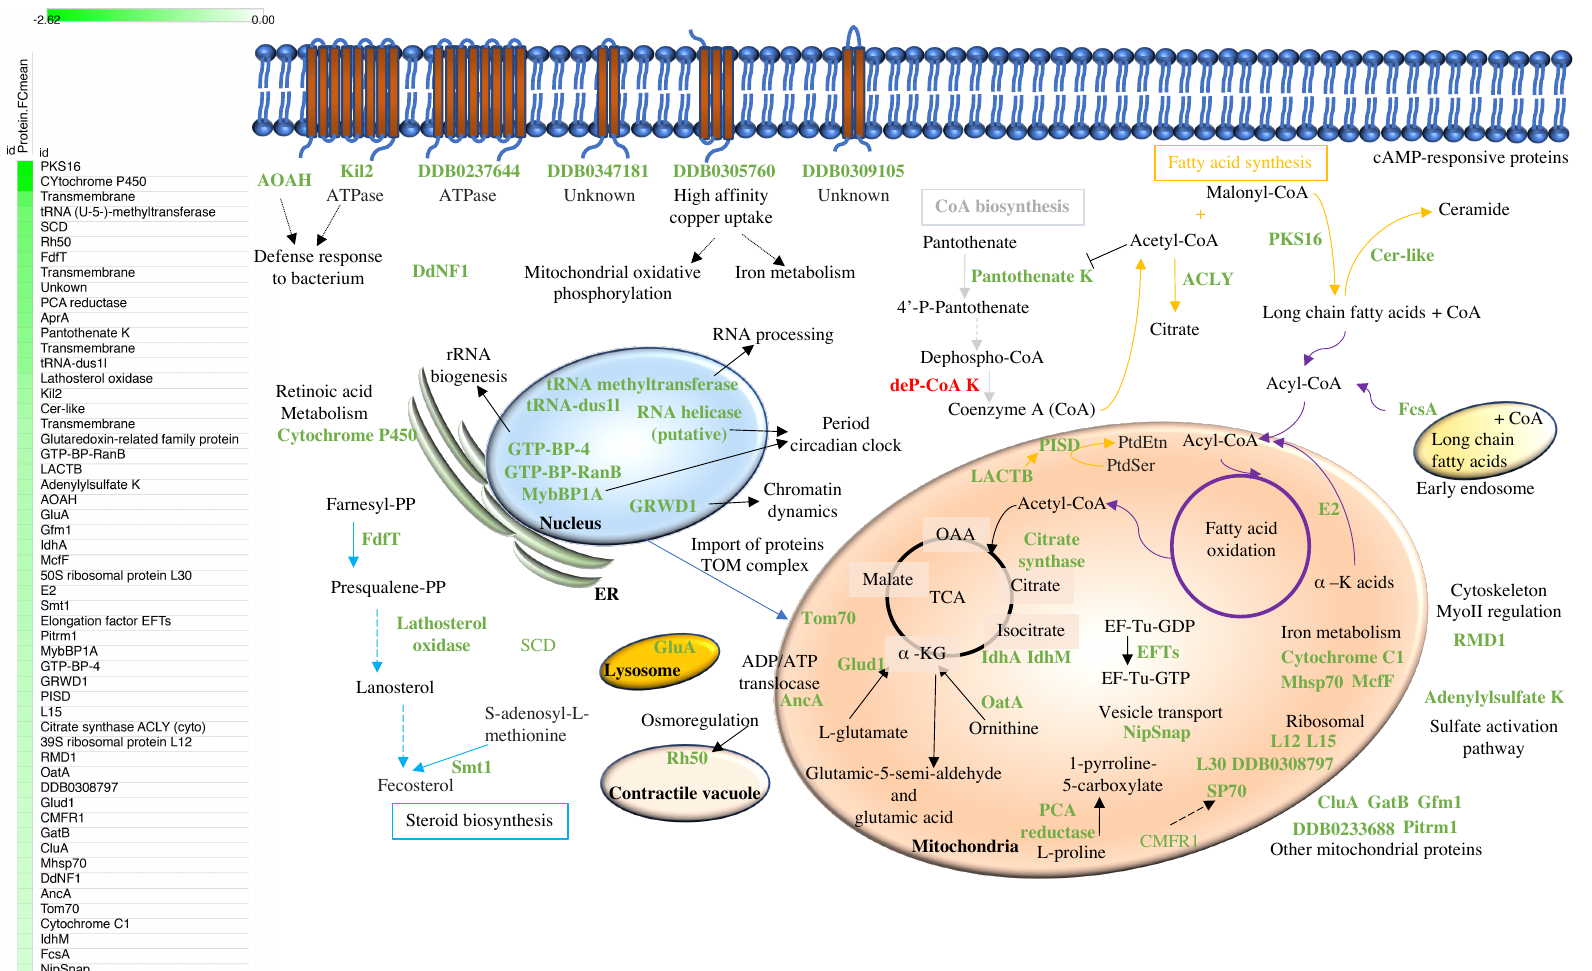
Figure 3. Diagram that illustrates the in situ flow of downregulated proteins (mark in green) in early development as a consequence of cAMP stimulation. Novel early developmentally regulated proteins are in bold. Arrows indicate direct interactions or contiguous proteins in a signaling / enzymatic cascade, whereas dotted arrows indicate they are part of the same signaling pathway or biological process but not